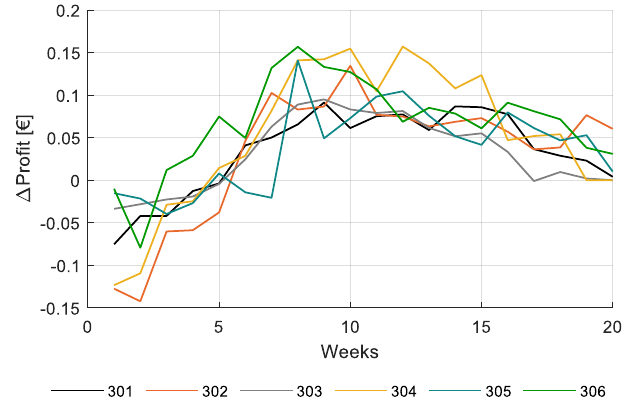
Figure 22. Change in simulated net profit (€/m 2 ) for additional +2 illumination hours for each individual week while maintaining the remaining illumination strategy unchanged for the different greenhouse compartments (301 – 306).